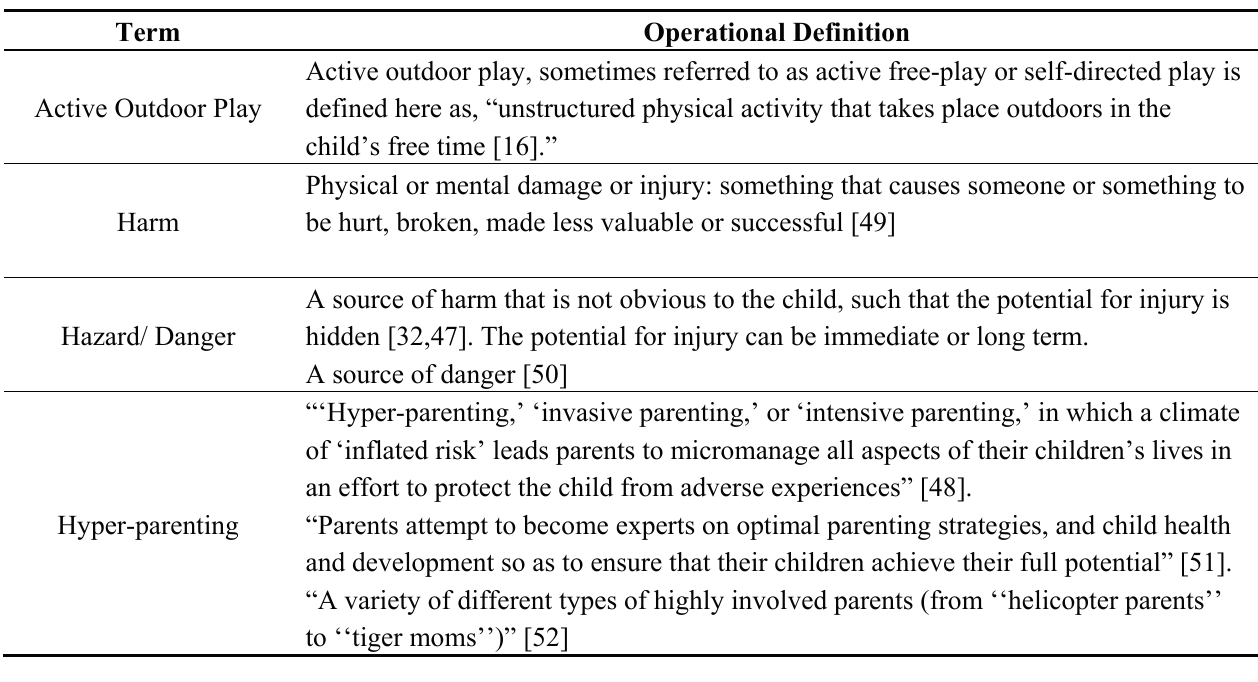
Table 1. Operational definitions of key